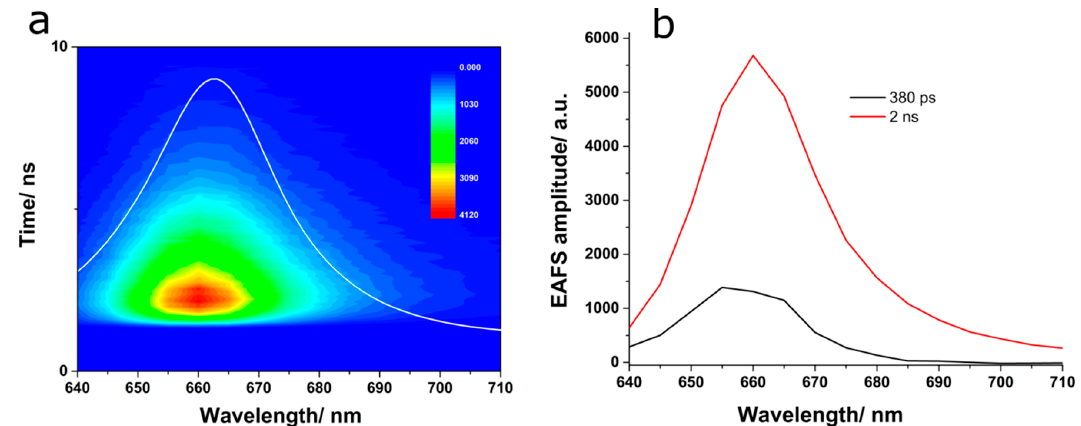
Figure 5. ( a ) Time-correlated single photon counting (TCSPC) data showing the three-dimensional carpet obtained from allophycocyanin (APC) when pumped at 580 nm. The white line corresponds to the steady-state fluorescence spectrum; ( b ) Evolution-associated fluorescence spectra as obtained from global analysis using a sequential model.